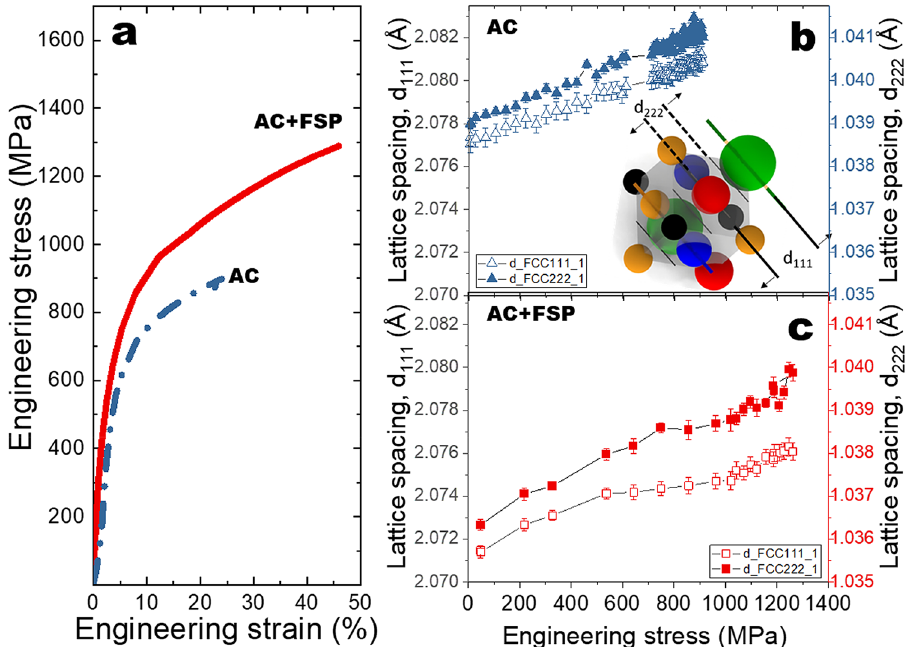
Figure 2. ( a ) Engineering stress–strain curves for as-cast and friction stir processed (AC and AC + FSP, respectively) conditions during in-situ neutron diffraction experiments. The lattice strain as a function of engineering stress for: ( b ) AC, and ( c ) AC + FSP conditions. Here lattice spacings are shown to correlate with the schematic representation of d 222 and d 111 planes and Eq. 1 with Figures ( b ) and ( c